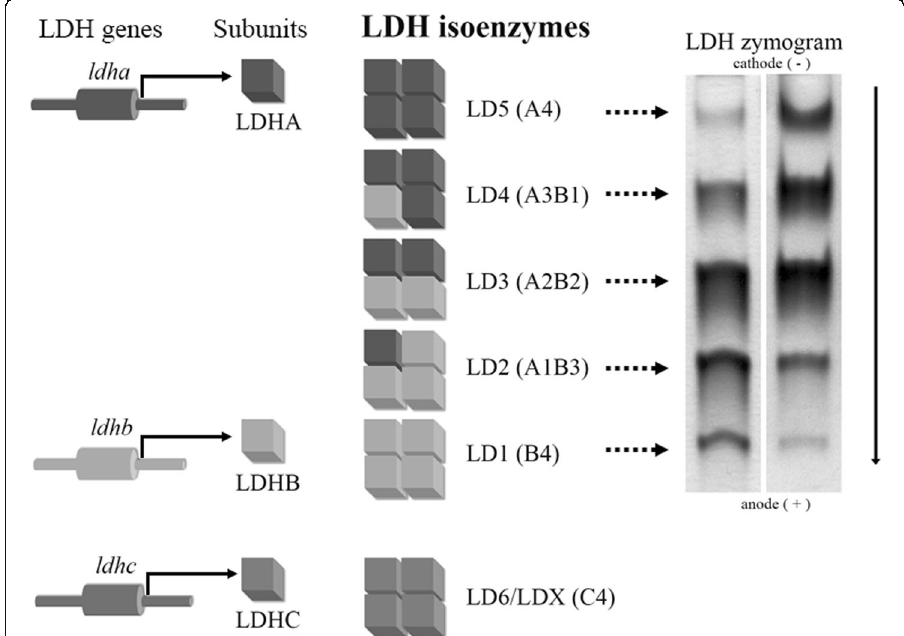
Fig. 1 Scheme showing the LDH reaction. LDH catalyzes the reversible conversion of pyruvate to lactate with NADH as a cofactor during glycolysis . The LD5 isoform preferentially catalyzes the reduction of pyruvate into lactate and thus prevents entry of pyruvate to the tricarboxylic acid (TCA) cycle. The NADH oxidation allows the regeneration of NAD+ molecules, which are needed for the continuous generation of ATP to maintain glycolysis. By contrast, the LD1 is predisposed to convert lactate into pyruvate with the concomitant generation of